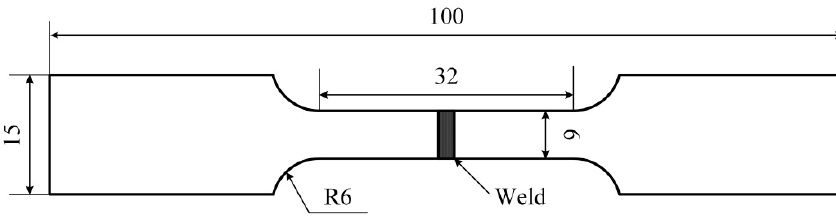
Figure 3. The sample size of tensile test (mm).